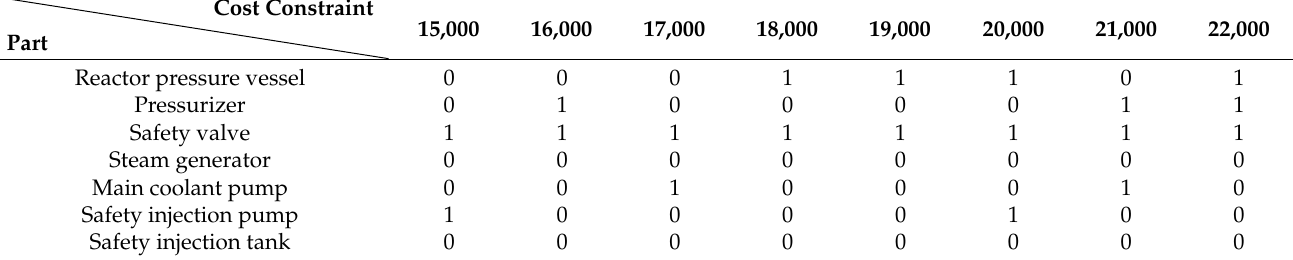
Table 5. X11 failure, t = 600 h.